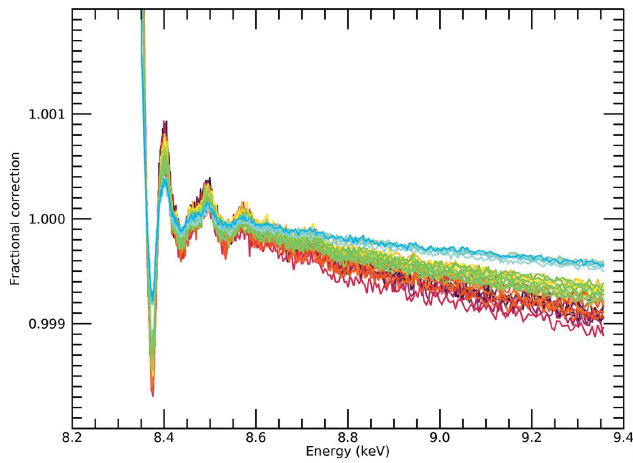
Figure 9 For the i -pr data set, the effect of the ð (cid:3)=(cid:4) Þ (cid:3) component of the inversion formulae is (cid:8) 0.2% at the edge and 0.05% in the oscillations and background [equation